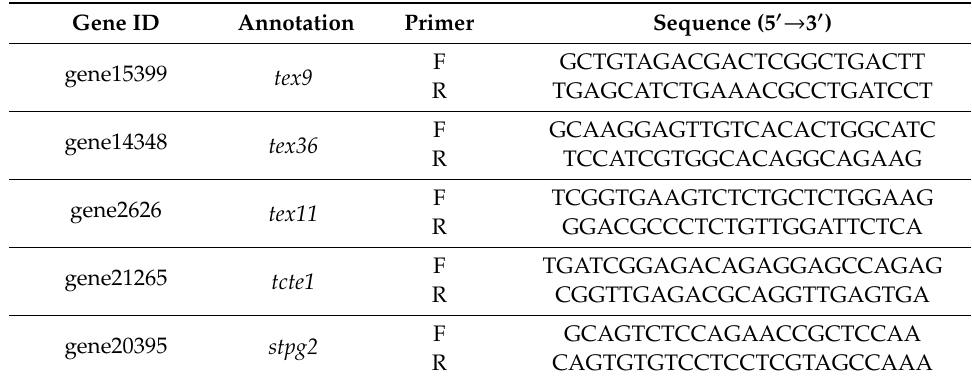
Table 2. Primers used for